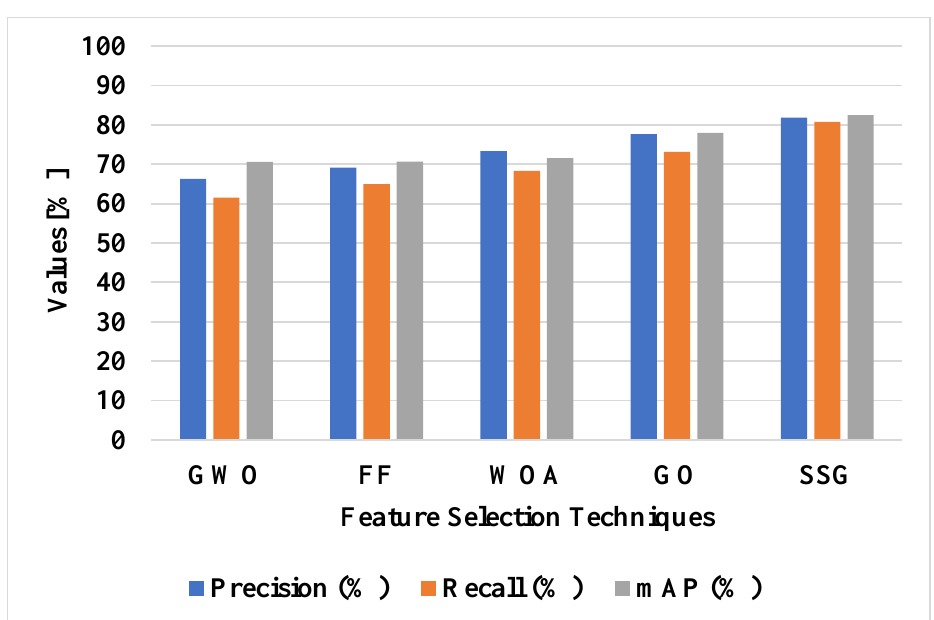
Figure 7. Performance of feature selection techniques on DOTA dataset. Table 2. Feature selection techniques performance on DOTA dataset.